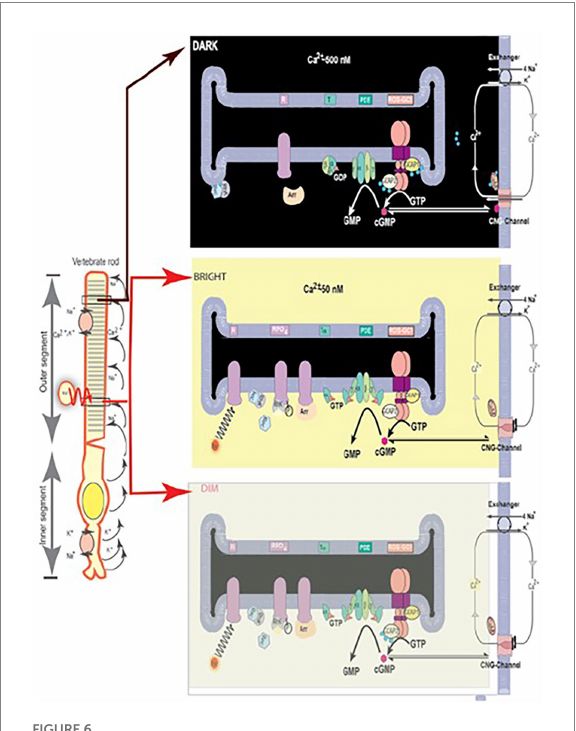
FIGURE 6 Schematic representation of the luminosity-dependent operation of the ROS-GC-GCAP transduction system. Left panel. An illustration of a typical vertebrate rod. In the DARK a circulating current (arrows) is present. It is outward in the inner segment and carried primarily by K + ; in the outer segment the net charge is inward, with about 90% of the inward flow carried by the Na + and 10% by Ca 2+ ions. Na + /K + exchange pumps in the inner segment membrane and Na + /K + -Ca 2+ exchangers in the outer segment membrane (see also right panels) maintain the overall ionic gradients against the dark flows. The capture of a photon (h ν ) by a rhodopsin molecule in one of the disc membranes of the outer segment initiates the photo-transduction cascade. Right upper panel, DARK. The components of the Photo-Transduction cascade are shown in the dark/resting steady-state. Cytoplasmic cyclic GMP (red circle), generated by the basal catalytic activity of ROS-GC, keeps a fraction of CNG channels in the plasma membrane open. ROS-GC1 via its 415 M-L 456 segment is GCAP1-and via 965 Y-N 981 is GCAP2-bound. Ca 2+ ions enter the cell via the CNG-channel and are extruded via the Na + /K + , Ca 2+ -exchanger. Synthesis and hydrolysis of cyclic GMP by ROS-GC and PDE, respectively, occur at a low rate. The heterotrimeric G protein, transducin, is in its GDP- bound state and is inactive. The Ca 2+ binding proteins calmodulin (CaM), recoverin (Rec) are bound to their target proteins, the CNG- channel, rhodopsin kinase (Rhk), respectively. Right middle panel. Absorption of BRIGHT LIGHT by the visual pigment rhodopsin leads to the activation of the transduction cascade: the GTP-bound α -subunit of transducing activates PDE that rapidly hydrolyzes cyclic GMP. Subsequently, the CNG-channels close and the Ca 2+ - concentration falls. The fall in cytoplasmic [Ca 2+ ]i is sensed by Ca 2+ - binding proteins: CaM dissociates from the CNG-channel what leads to an increase in cyclic GMP sensitivity of the channel; recoverin stops inhibiting rhodopsin kinase; rhodopsin becomes phosphorylated. Both Ca 2+ -free GCAPs in their changed configurations activate ROS-GC and synthesis of cyclic GMP increases. Arrestin (Arr) binds to phosphorylated rhodopsin and interferes with the binding and further activation of transducin. Enhancement of cyclic GMP synthesis brings it to its original DARK state level and termination of the cascade, which leads to reopening of CNG channels. Right bottom panel, DIM LIGHT. The initial fall of [Ca 2+ ] i is selectively detected only by GCAP1. In its Ca 2+ - free state GCAP1attains the activated mode and stimulates ROS-GC activity. GCAP2 remains Ca 2+ -bound and in its inhibitory mode. (Reproduced from Sharma and Duda,